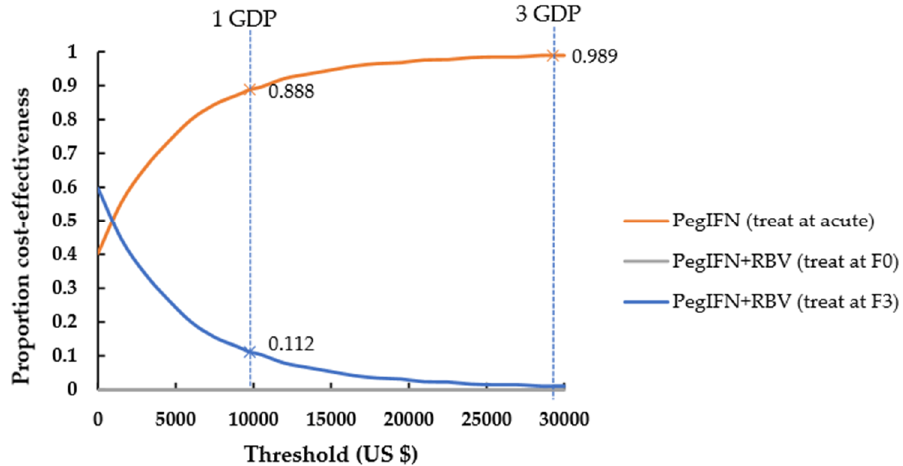
Figure 3. Cost-effectiveness acceptability curves when only PegIFN-based regimen was available. F0, no fibrosis; F3, numerous septa without cirrhosis; GDP, gross domestic product. IFN, interferon; DCV, Daclatasvir; ASV, Asunaprevir; RBV, ribavirin.